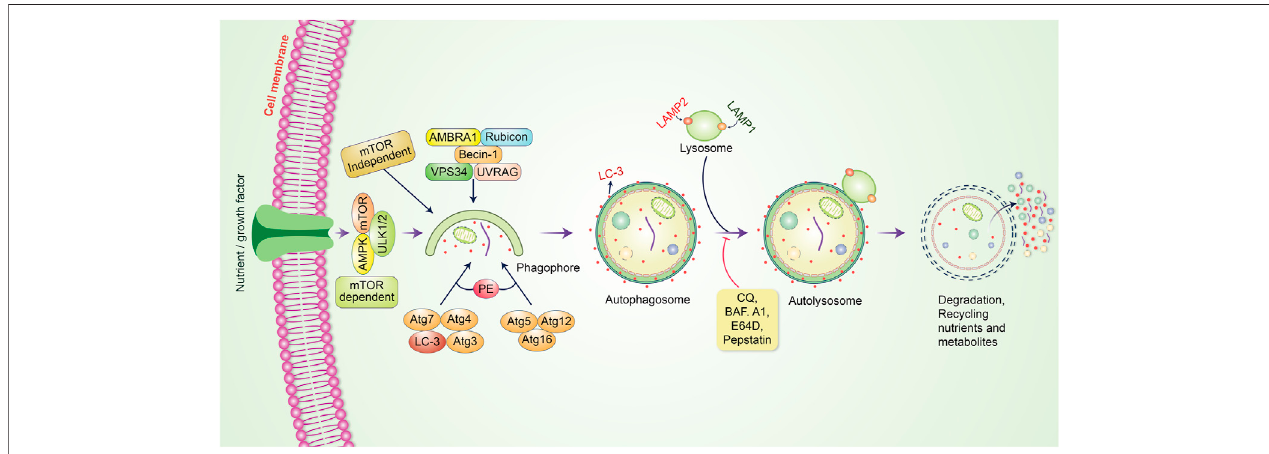
FIGURE 1 | Molecular mechanism of the autophagic pathway. Autophagy is initiated by the formation of a pre-autophagosomal structure. PI3K-AMPK and mammalian target of rapamycin (mTOR) contribute to the formation of the pre-autophagosomal structure. ULK1, Vps34 and the Beclin-1 complex help to activate phagophore formation. After phagophore nucleation is elongated, subsequent binding to autophagosome occurs. Binding between mature autophagosome and lysosome results in autolysosome formation. Finally, autolysosomes are eliminated through acid hydrolases, which produce nutrients and recycling